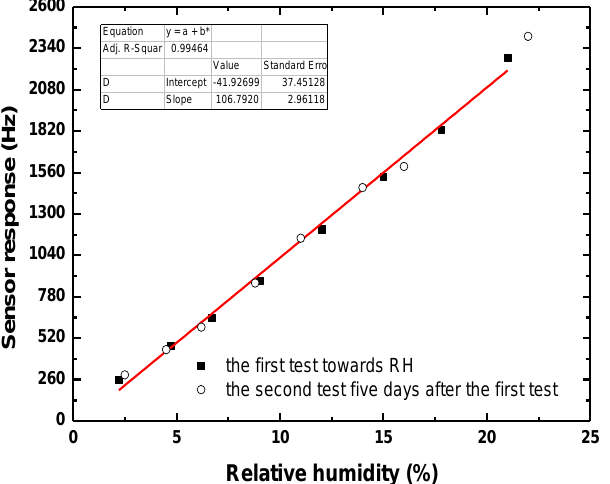
Figure 8. The sensor response towards low humidity and sensor stability testing.